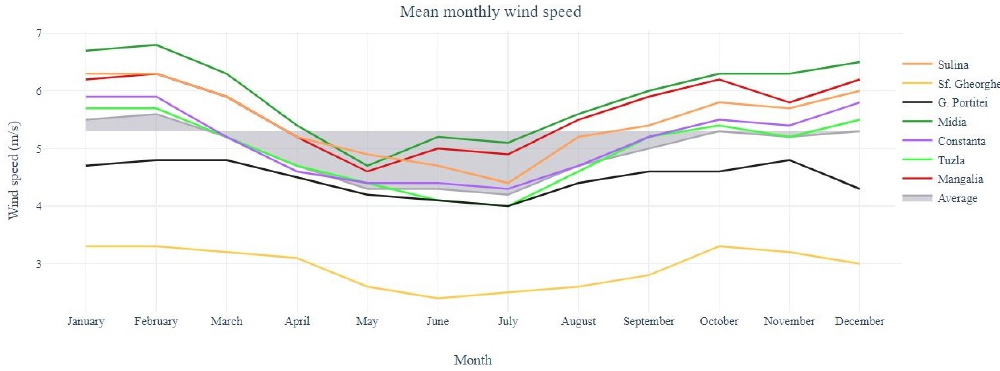
Figure 3. Mean monthly values of the wind speed.